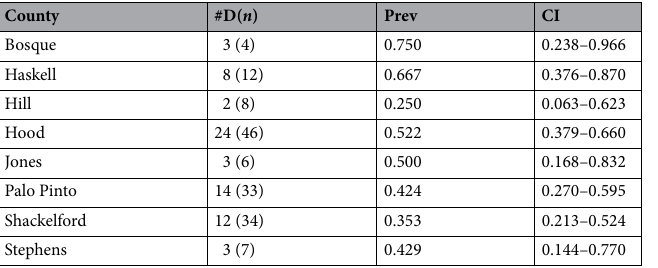
Table 2. Texas counties sampled for Nerodia rhombifer , N. e. transversa , and N. h. harteri , the number of snakes that tested positive for Ophidiomyces ophiodiicola (#D) among the total collected in each county ( n ), the estimated prevalence as a proportion (Prev.), and the 95% binomial confidence intervals for each estimate (CI).